Question: State the chart type depicted above.
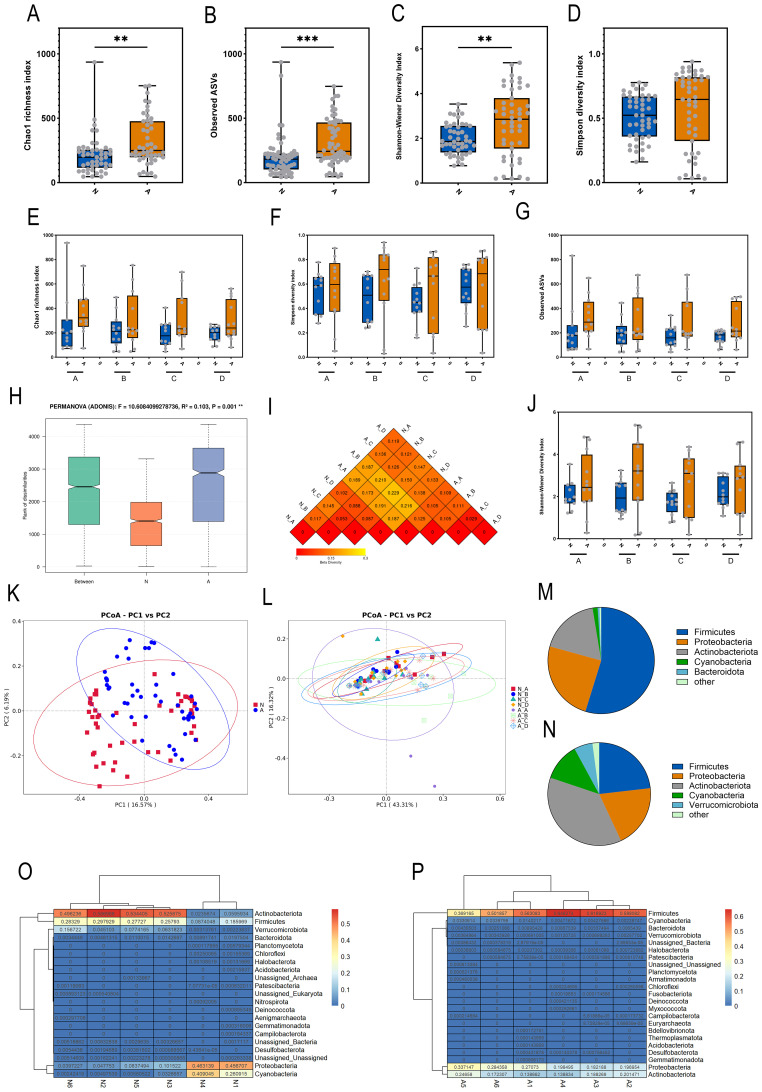
Answer: heatmap